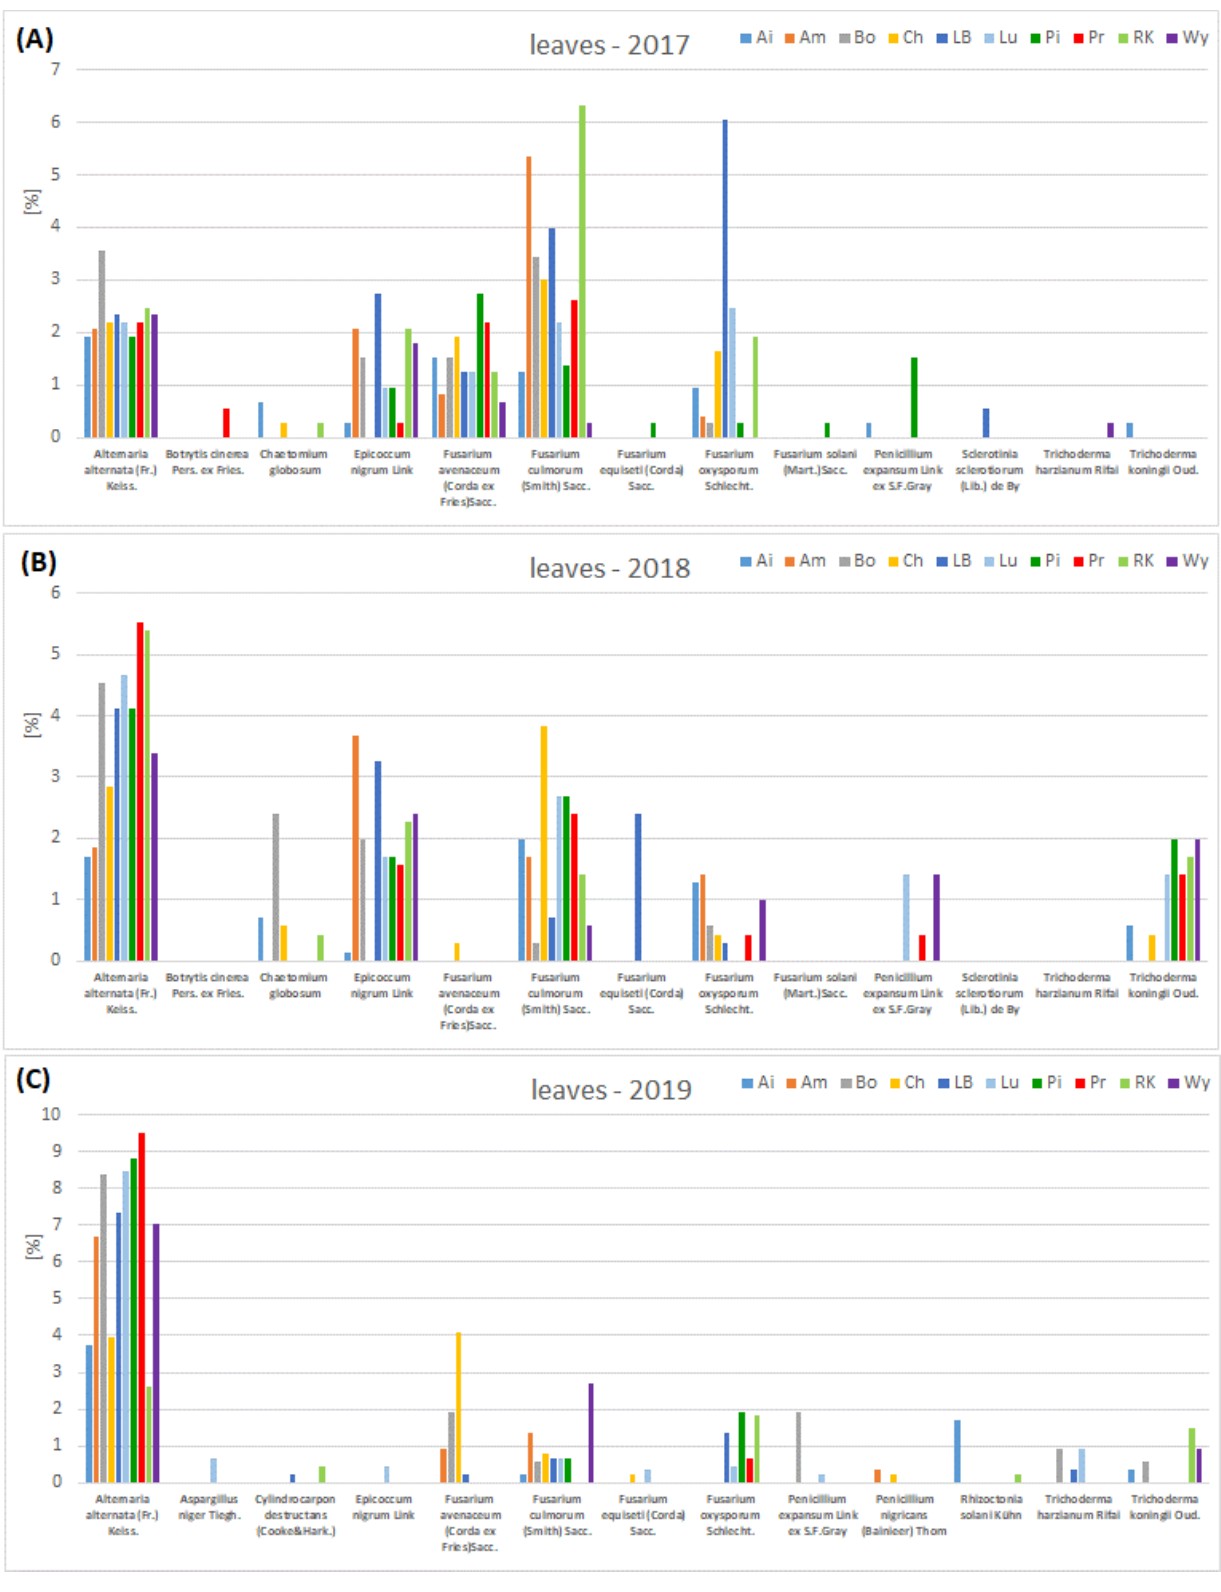
Figure 7. Fungi colonizing leaves of canna in particular year of research. Description of cultivars is given in Materials and Methods Section 2.1.